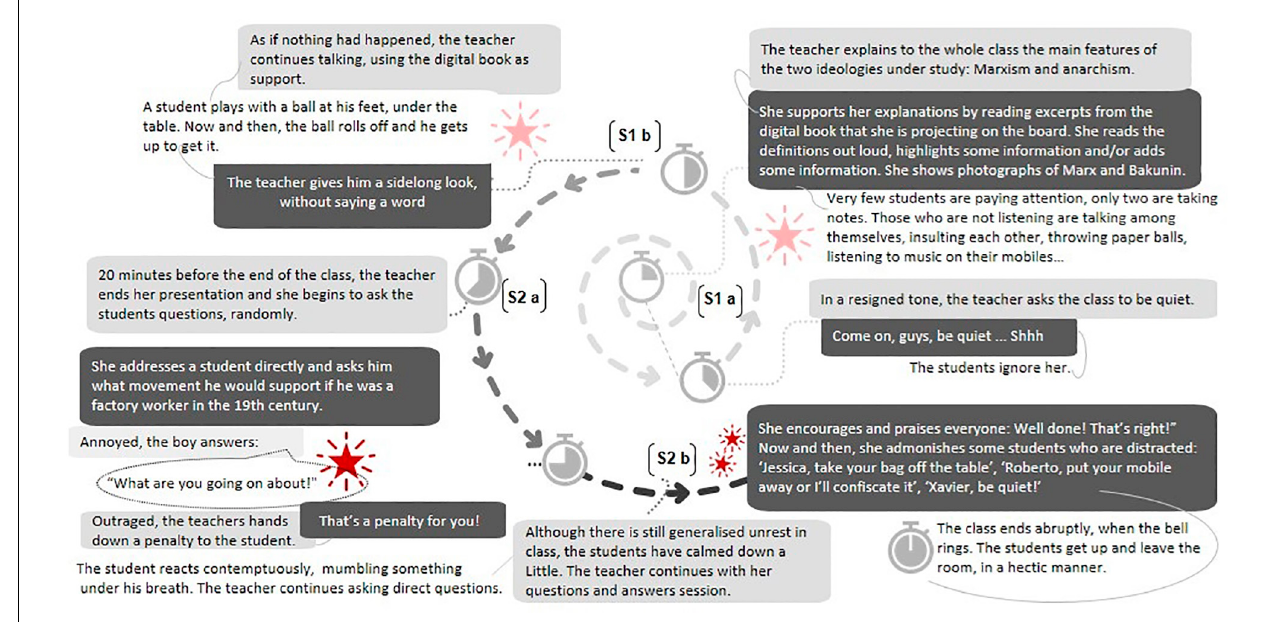
FIGURE 2 | Causal network: Case A ‘The tale of the digital